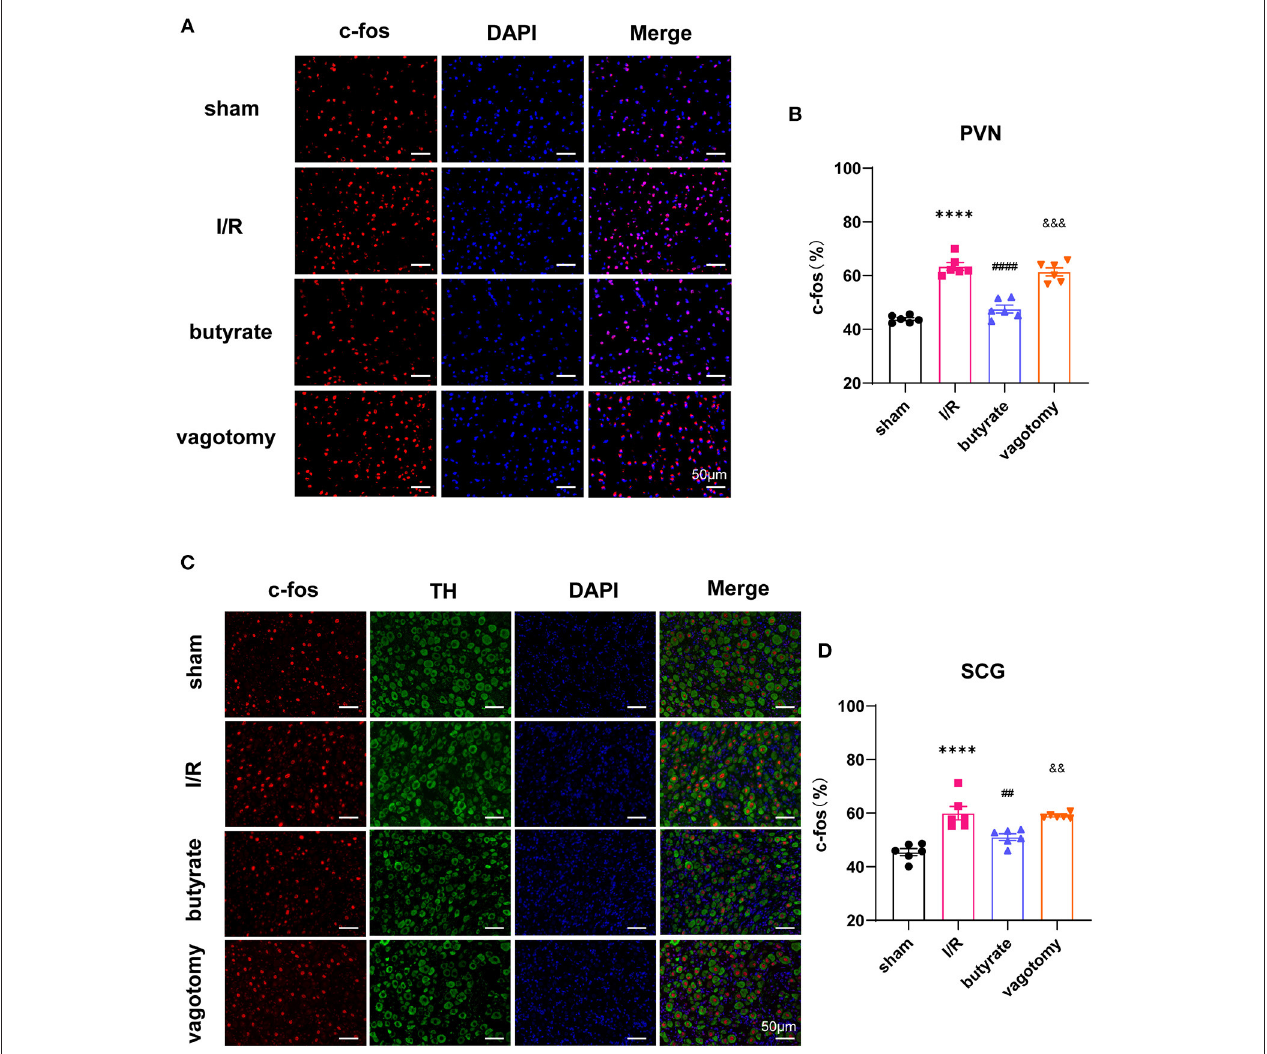
FIGURE 7 | Butyrate treatment suppressed the central sympathetic nervous system and sympathetic outflow to the heart, and vagotomy diminished this protective effect. (A) Representative immunofluorescence staining for c-fos in the PVN in all groups. (B) Quantitative analysis of c-fos expressed as percentage of DAPI stained cells. (C) Representative immunofluorescence staining for c-fos in the SCG in all groups. (D) Quantitative analysis of c-fos expressed as percentage of TH + stained cells. **** p < 0.0001 vs. sham group; ## p < 0.01, #### p < 0.0001 vs. I/R group; && p < 0.01, &&& p < 0.001 vs. butyrate group. DAPI, 4’,6-diamidino-2-phenylindole; I/R, ischemia/reperfusion; PVN, paraventricular nucleus; TH, tyrosine hydroxylase; SCG, superior cervical